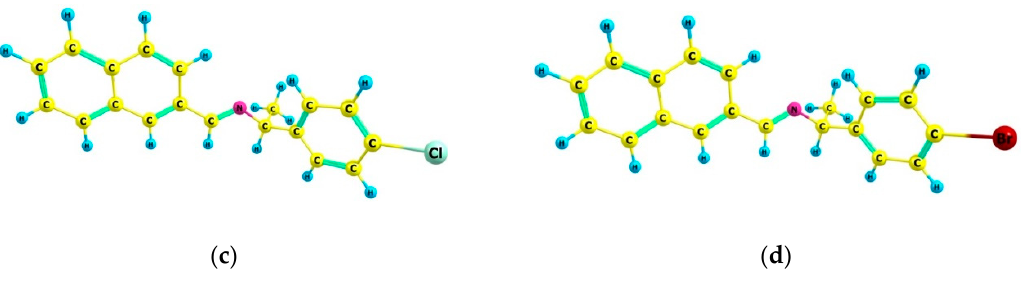
Figure 1. Molecular structures and schematic representation of ( a ) I , ( b ) I − F , ( c ) I − Cl , and ( d ) I − Br compounds.